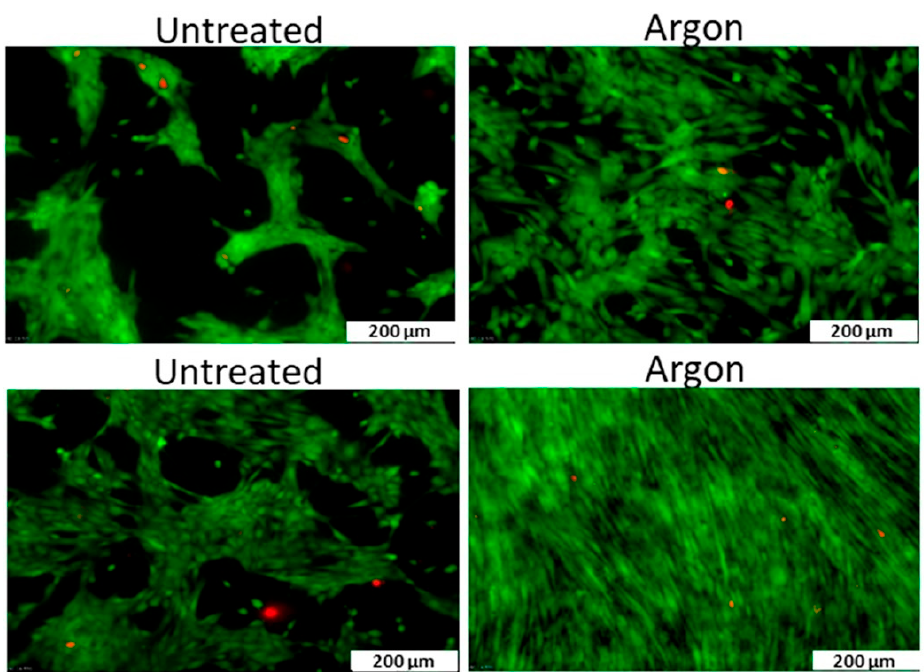
Figure 14. Fluorescent images one day ( top ) and seven days ( bottom ) post-seeding of human foreskin fibroblasts (HFF) cells after culturing on untreated and Ar plasma-modified PCL nanofibrous meshes—reproduced with permission from [106]. Copyright American Chemical Society, 2018.